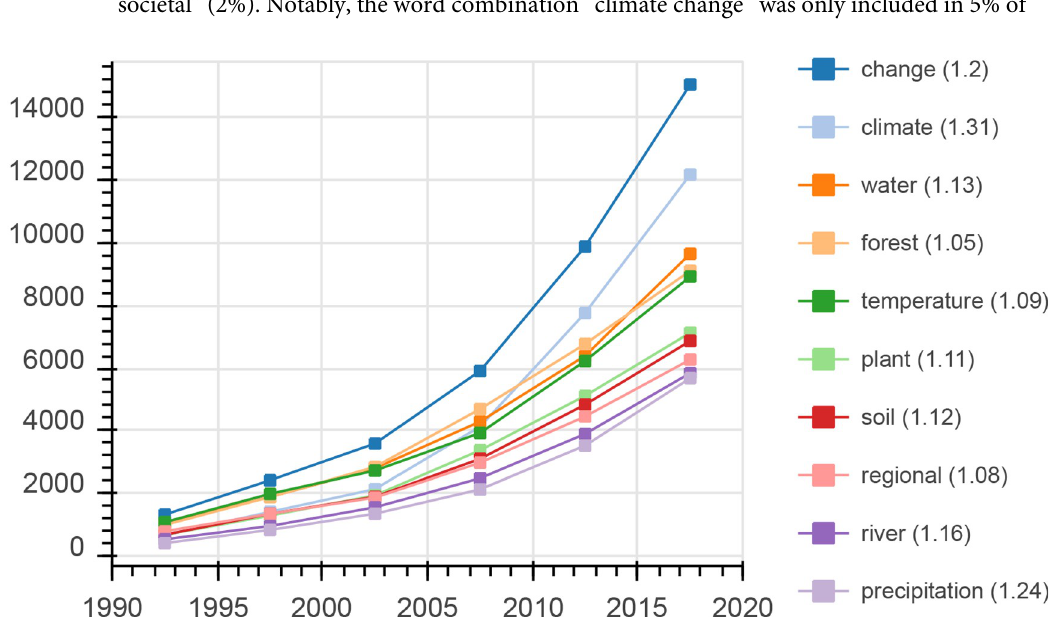
Fig 3. Number of abstract hits that contain a certain word for 5-year intervals from 1990–2019. Number in brackets is the Trend Index (see Eq 1) for 2015–2019.